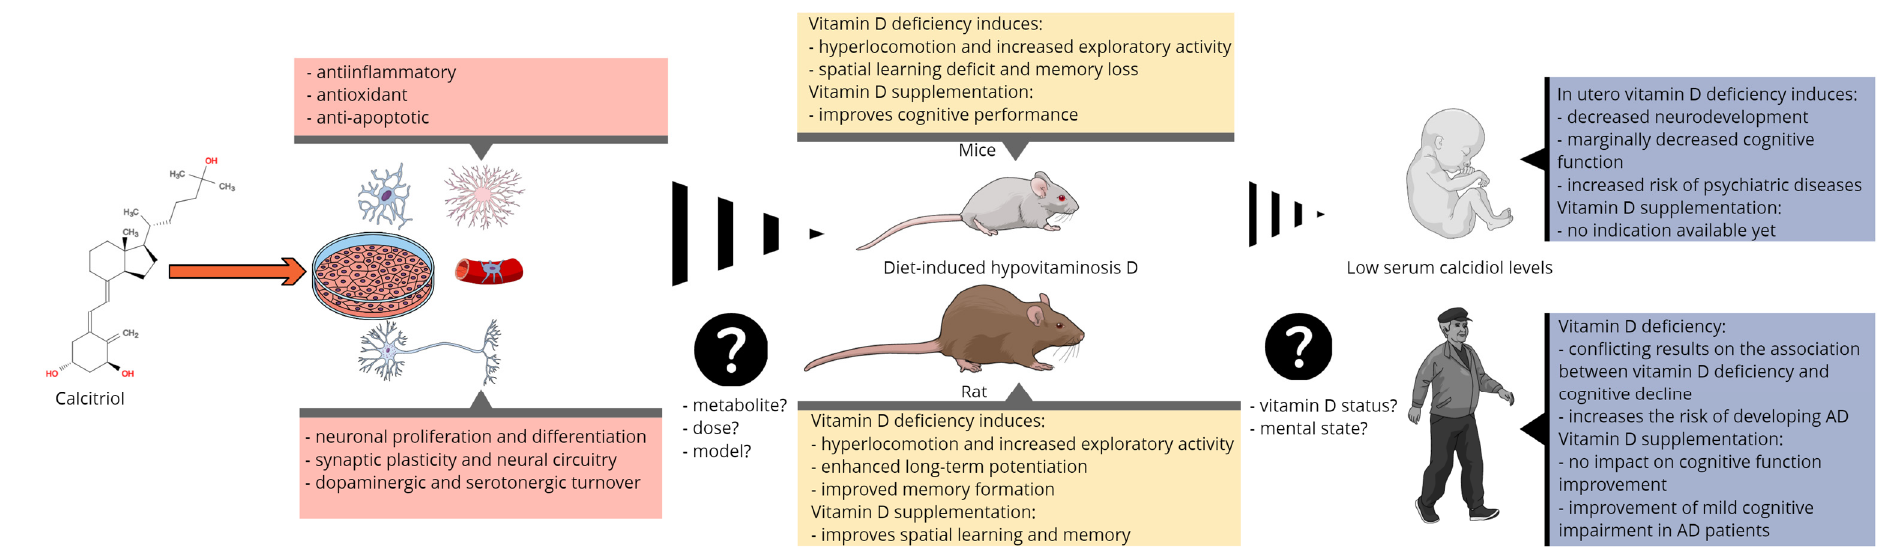
Figure 2. Summary of the main molecular, preclinical, and clinical findings linking vitamin D to cognitive function and the most important issues of translational research.